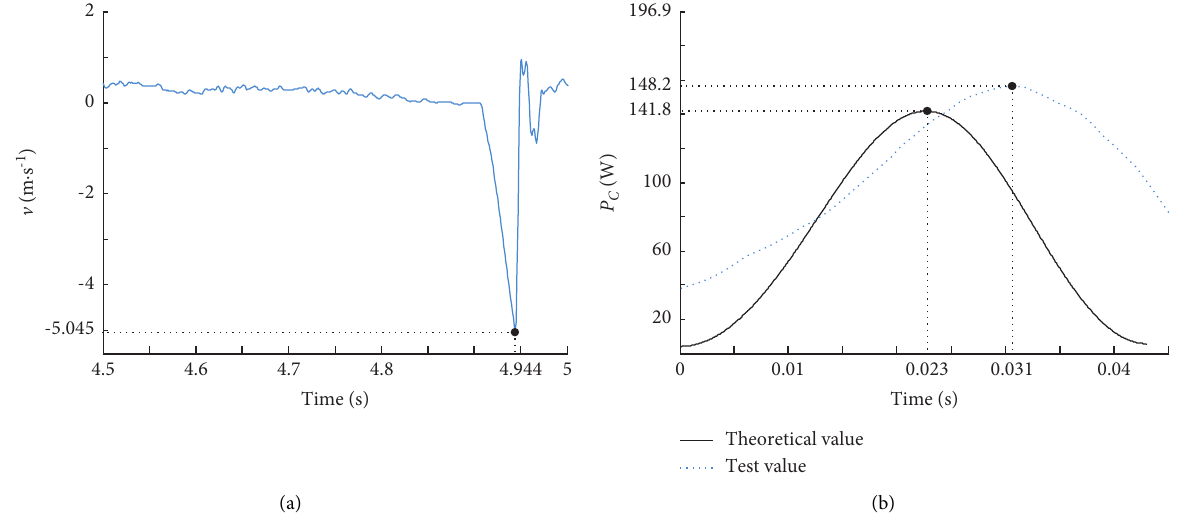
Figure 8: Curves of (a) velocity of the hammer and (b) percussive driving